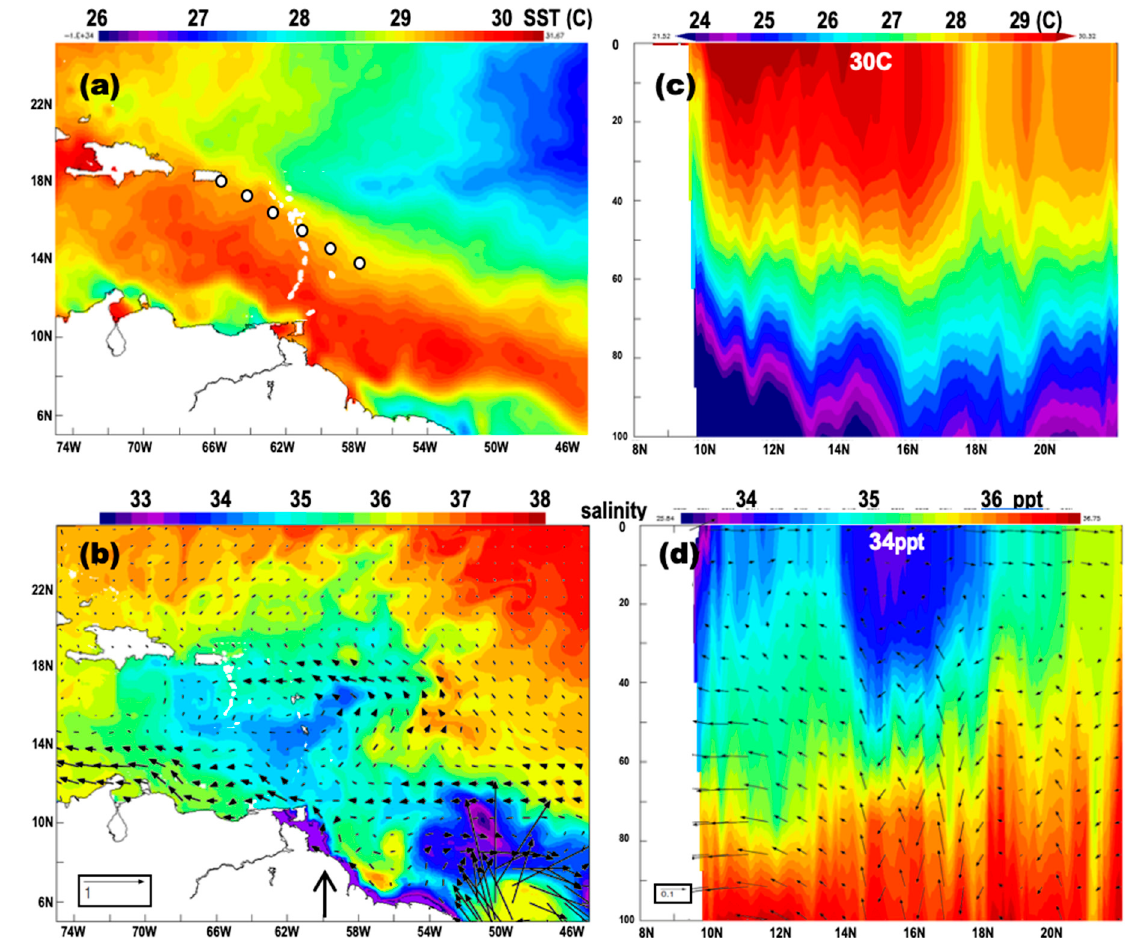
Figure 2. Pre-hurricane 5–15 September 2017 averaged: ( a ) Satellite SST and hurricane Maria 12-h positions from 00Z 18 September to 00Z 20 September (dots); ( b ) surface salinity and currents (vector) with arrow for N-S depth section on 60W: ( c ) Sea temperature, and ( d ) salinity with meridional circulation (vector) from HYCOM reanalysis.